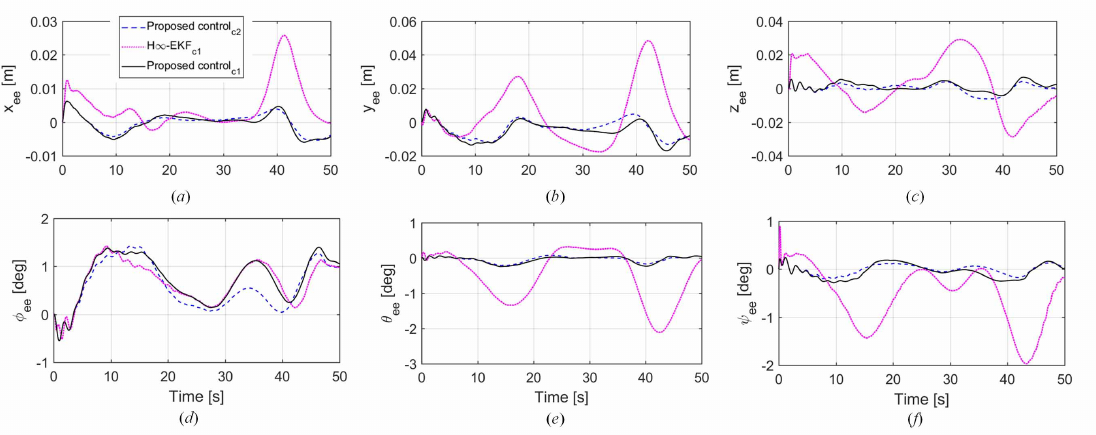
Figure 8. End-effector errors when tracking the circular trajectory. ( a ) x ee error, ( b ) y ee error, ( c ) z ee error, ( d ) tracking errors in the end-effector roll direction, ( e ) tracking errors in the end-effector pitch direction, ( f ) tracking errors in the end-effector yaw direction.